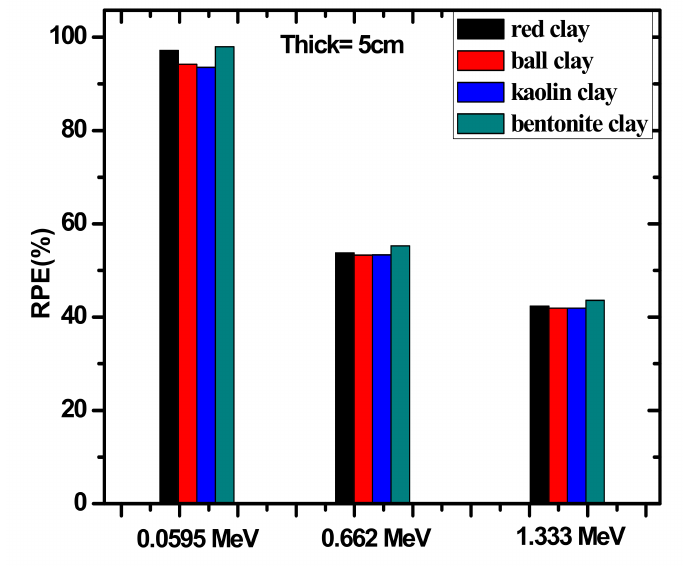
Figure 9. The experimental RPE values for the four investigated clay samples at three selected